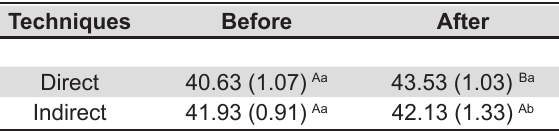
Different superscripted uppercase letters